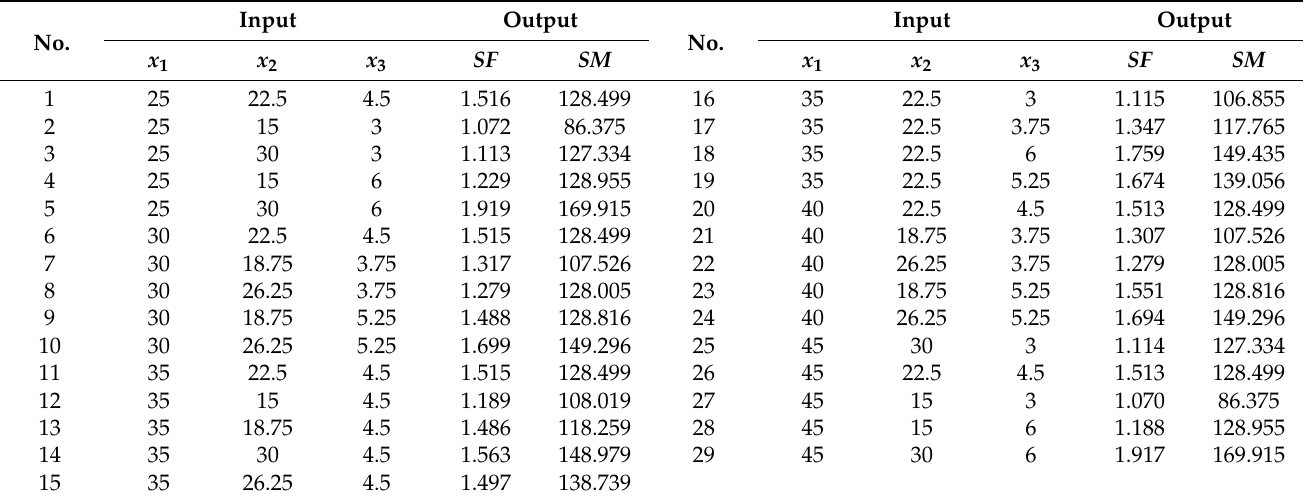
Table 6. Experimental data and finite element analysis